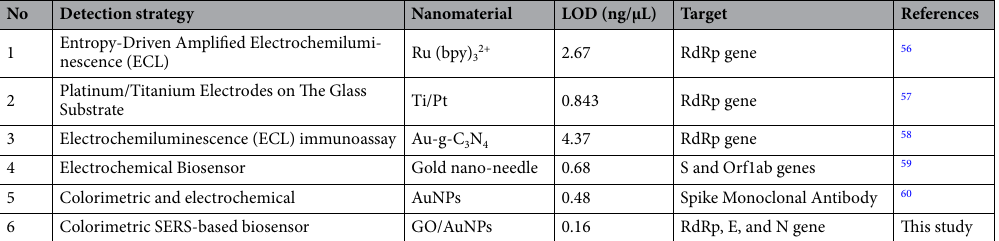
Table 1. Comparison of currently fabricated biosensor for detection of SARS-CoV-2.